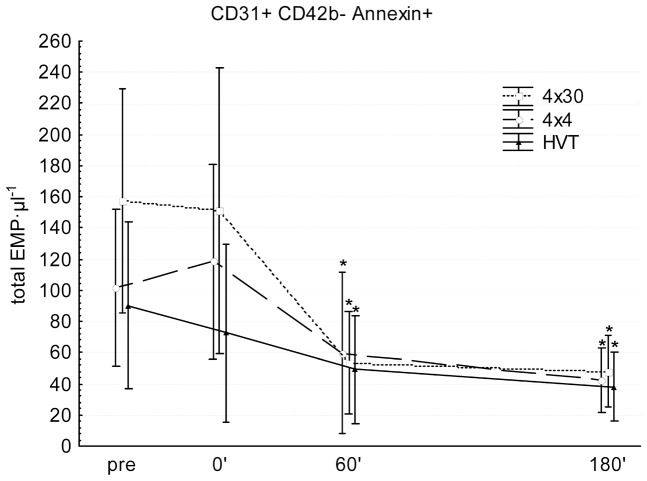
Changes in circulating EMP in conditioned serum of athletes.4×30 sec (Squares, dotted line), 4×4 min (circles, broken line) and HVT (triangles, solid line). * significantly different compared to pre-values (p≤0.05). Values are presented as means ± SD.